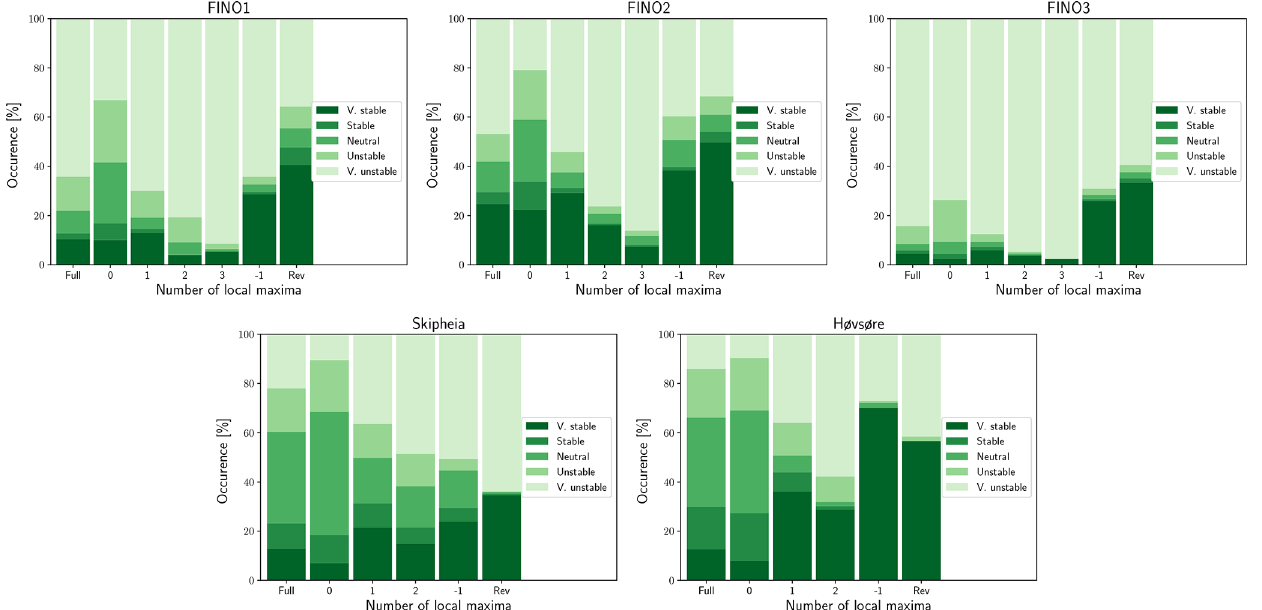
Figure 8. Stability distribution of profile categories at the five sites which had measurements enabling this analysis. Full indicates the entire data set with no abnormal profile